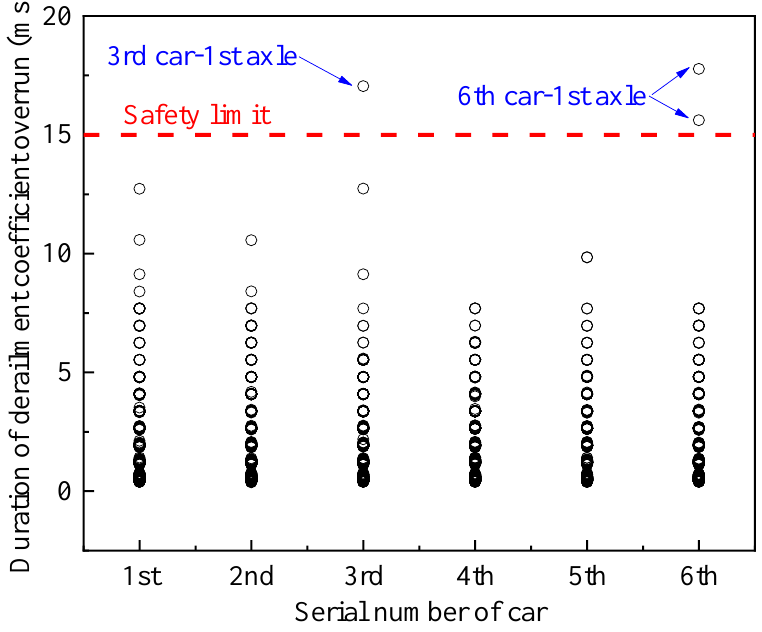
Figure 14. Statistical results of the duration of derailment coefficient overrun.